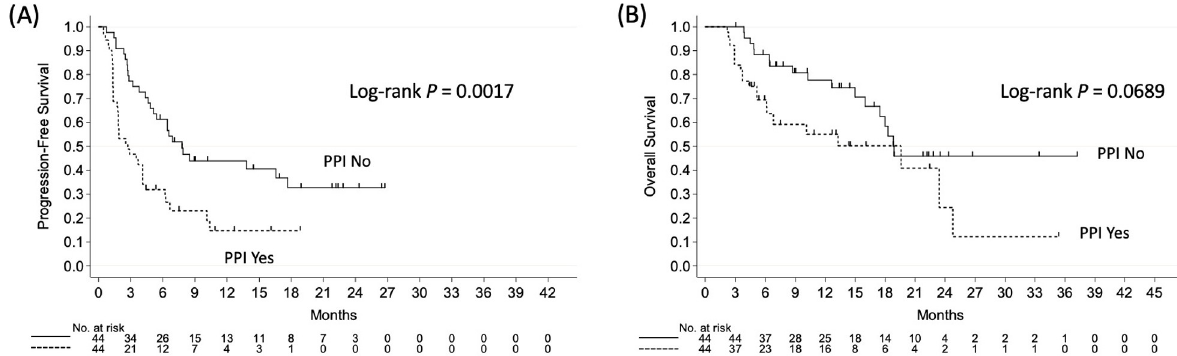
Fig 2. The inverse probability of treatment weighting-adjusted Kaplan–Meier curves according to the use or non-use of proton pump inhibitors. (A) The progression-free survival and (B) the overall survival.